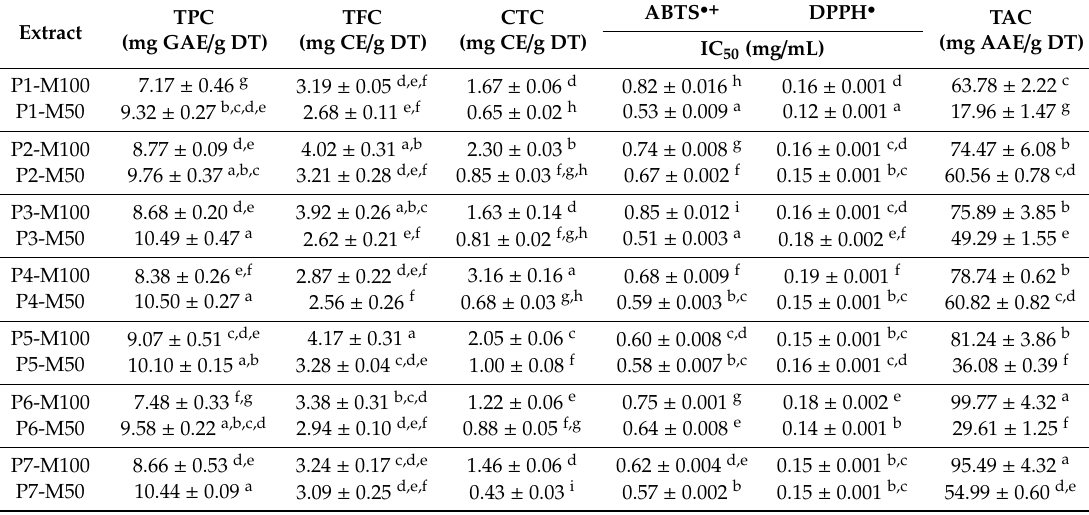
Table 1. Total phenolic, flavonoids, and tannins contents, free radical scavenging activity, and total antioxidant capacity of methanolic extracts from leaves of wild populations of Asclepias linaria . Extract